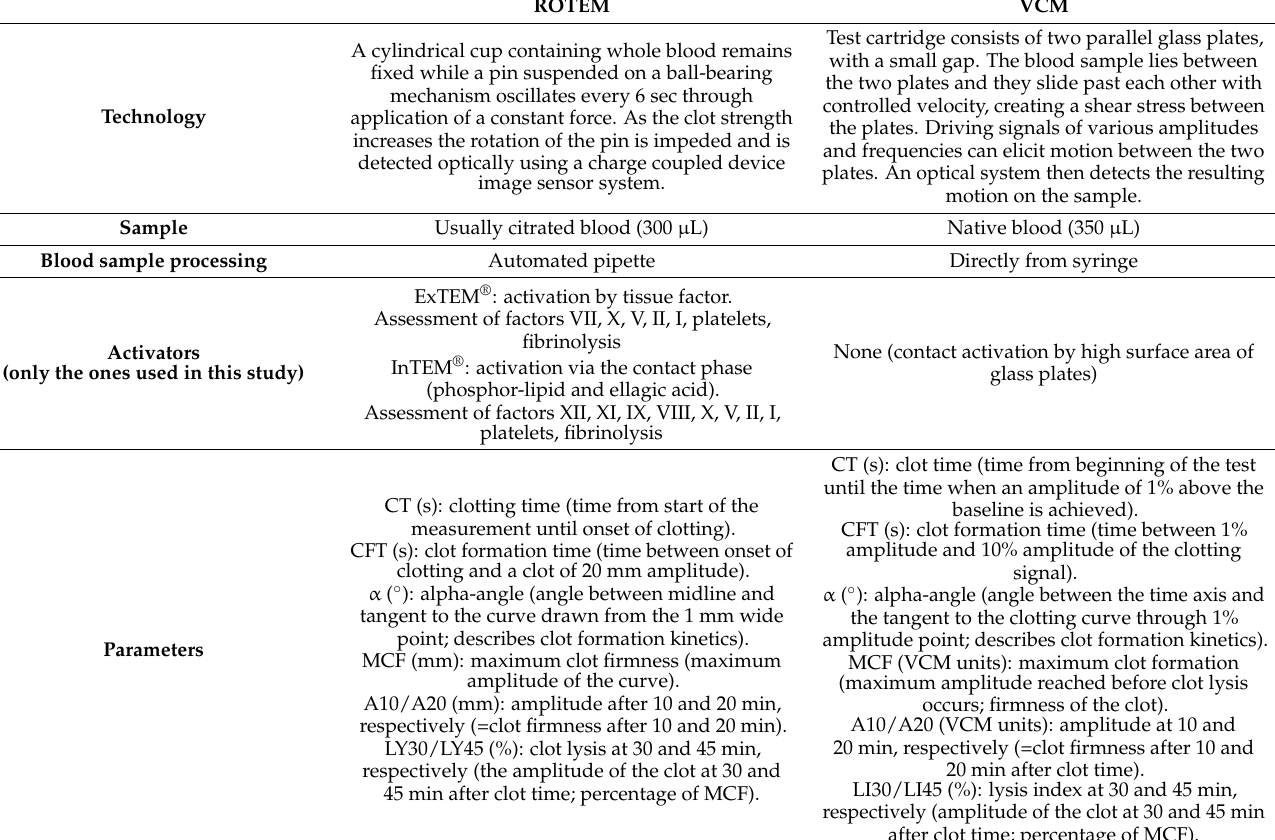
Table A1. Measurement techniques and parameters for coagulation analyses with ROTEM and